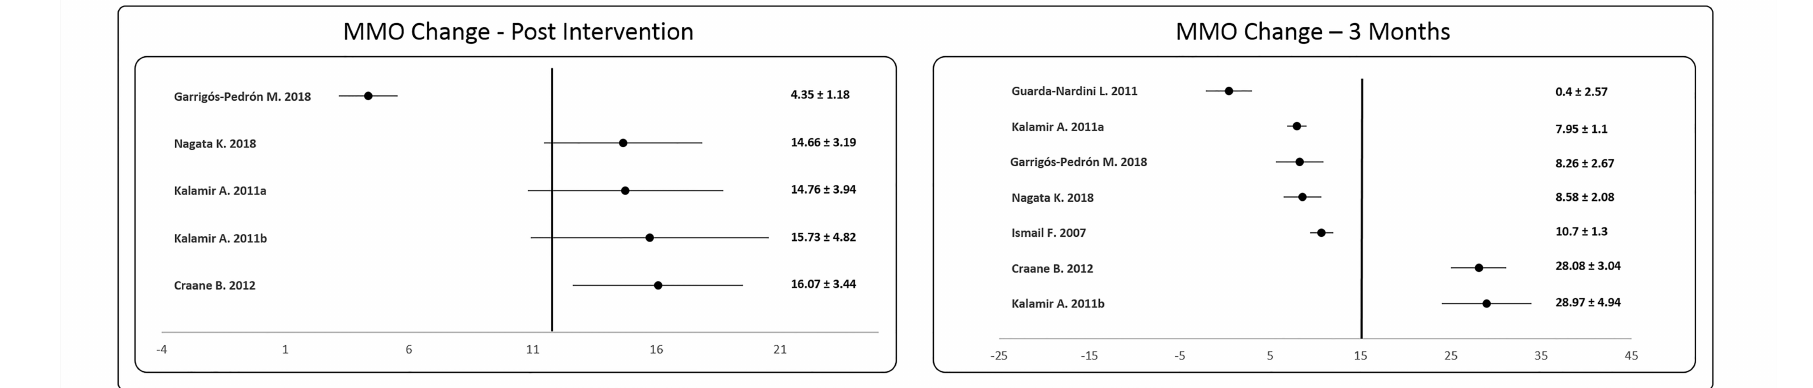
Figure 3. Forest plot of the changes in maximum mouth opening (MMO) after the intervention and three months form the